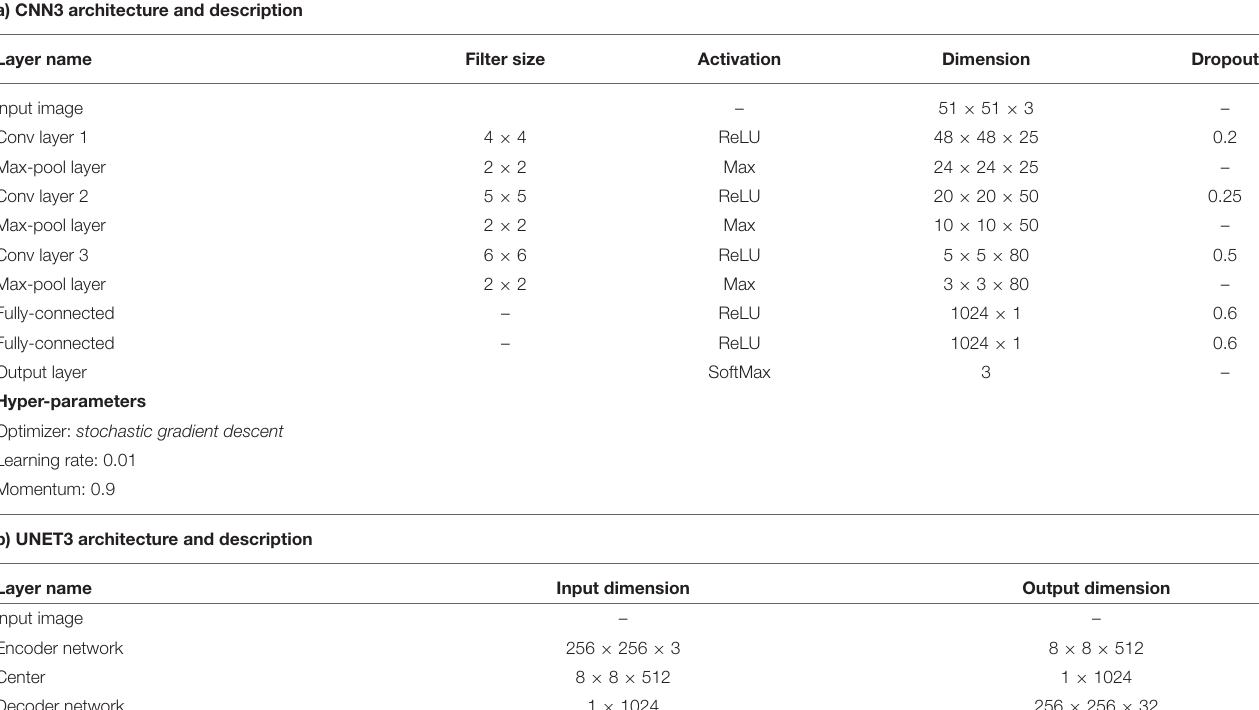
TABLE 1 | Description of deep CNN